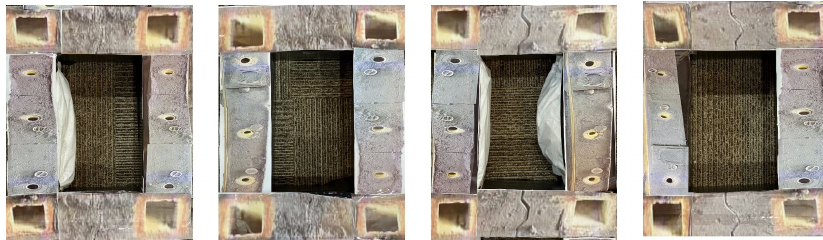
Figure 8. Raw heritage site data collected using the physical model.